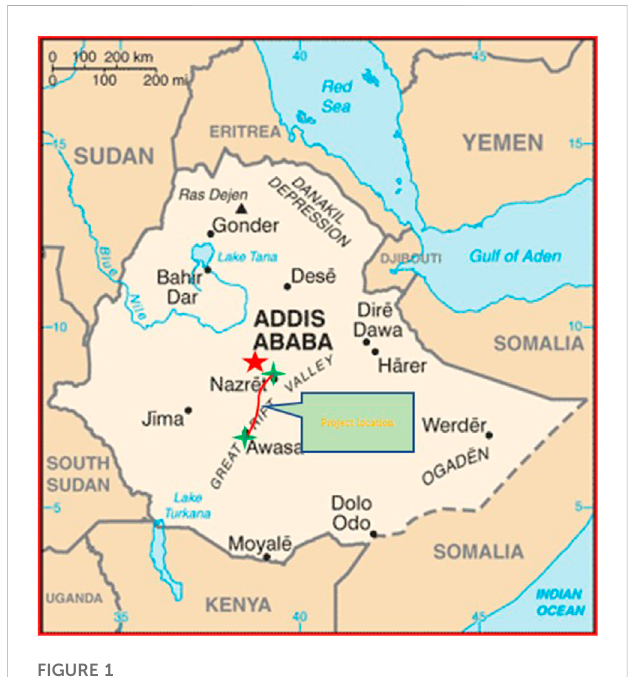
FIGURE 1 Geological map along the MH Highway.